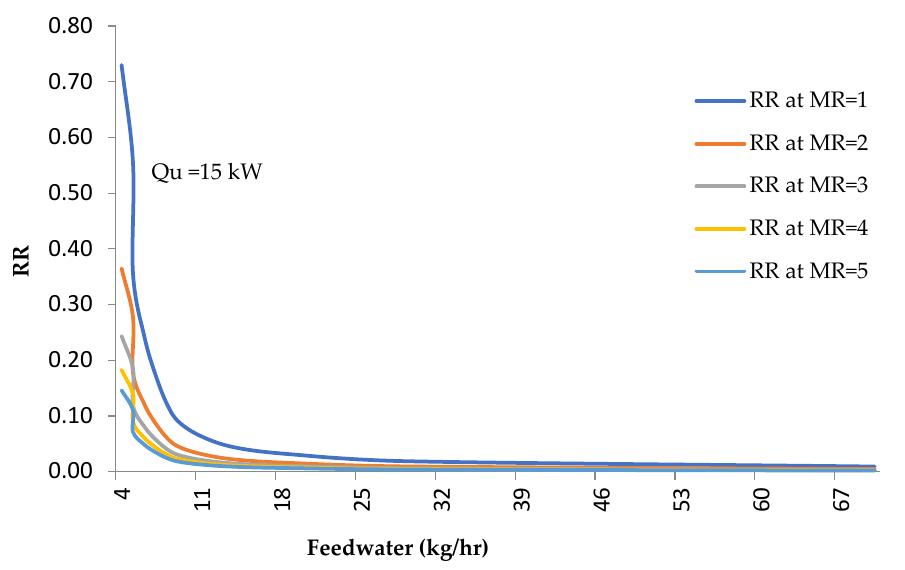
Figure 12. Effect of mass feed flow rate on recovery ratio.